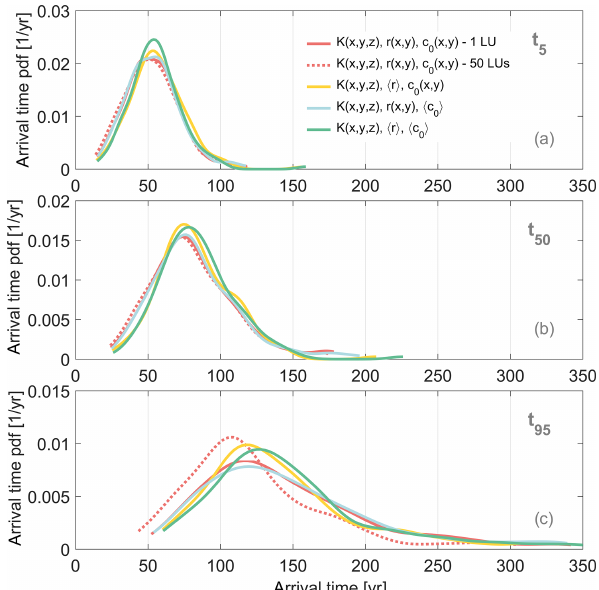
Figure 3. Probability density function of the time required for 5% (a) , 50% (b) , and 95% (c) of the total recorded mass to reach a well considering a heterogeneous r and heterogeneous c 0 (refer- ence case, red line); a homogeneous r and heterogeneous c 0 (yellow line); a heterogeneous r and homogeneous c 0 (light blue line); a ho- mogeneous r and homogeneous c 0 (green line). Plain lines refer to the consideration of an identical land-use map for all realizations. For comparison, the red dashed lines show outputs from simulations with realization-dependent land-use